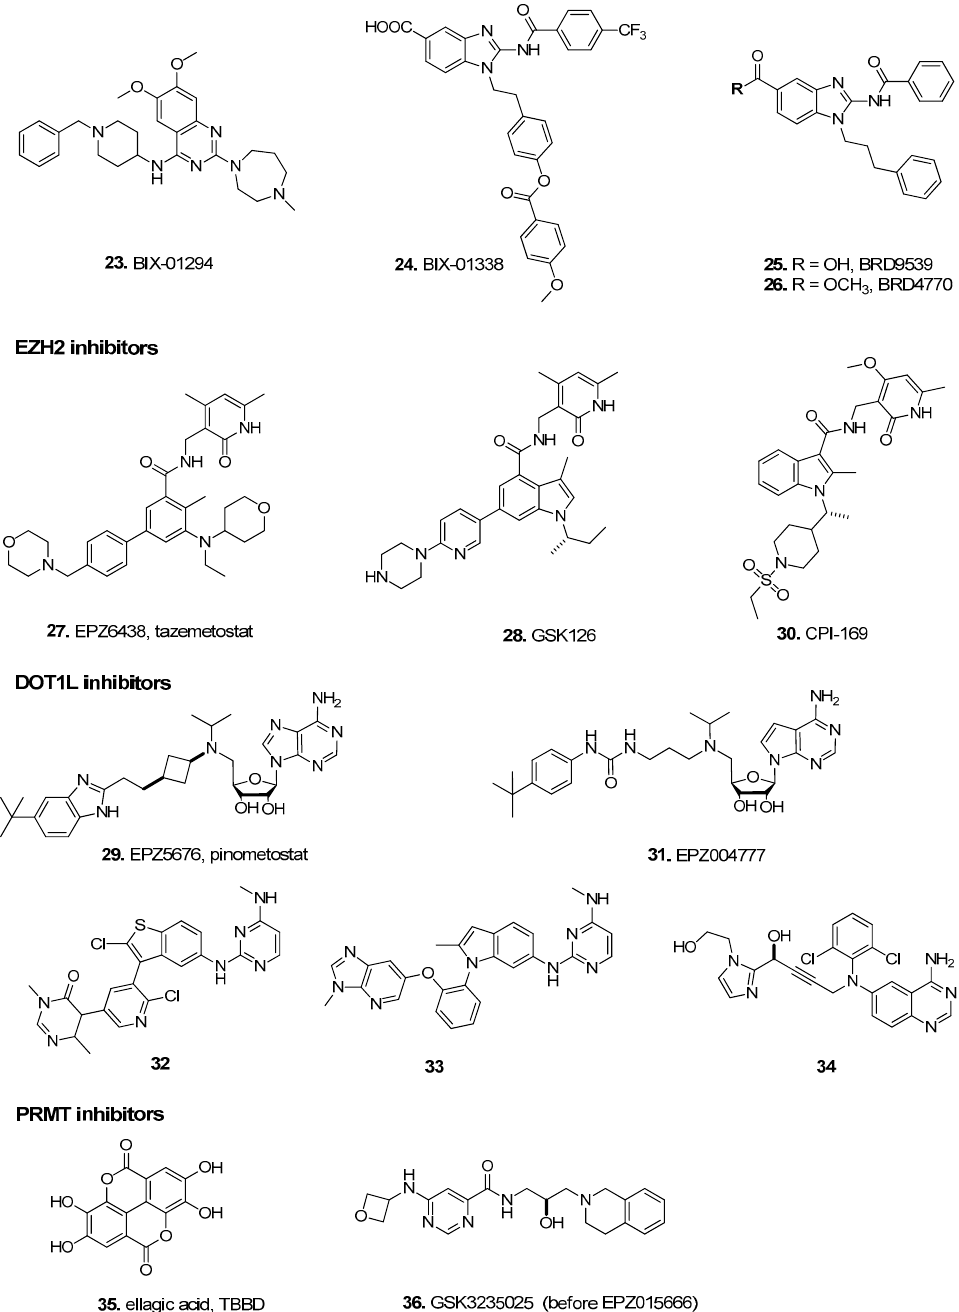
Figure 4. Structures of selected histone methyltransferases (HMT) inhibitors. G9a: euchromatic histone ‐ lysine N ‐ methyltransferase 2; GLP: G9a ‐ like protein; EZH2: enhancer of zeste homolog 2; DOT1L: disruptor of telomeric silencing 1 ‐ like; PRMT: protein arginine N ‐ methyltransferase.